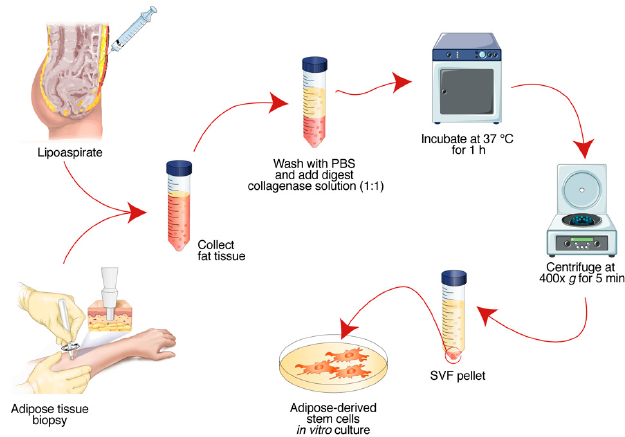
Figure 2. The figure shows the main steps for generating ASCs from lipoaspirate or